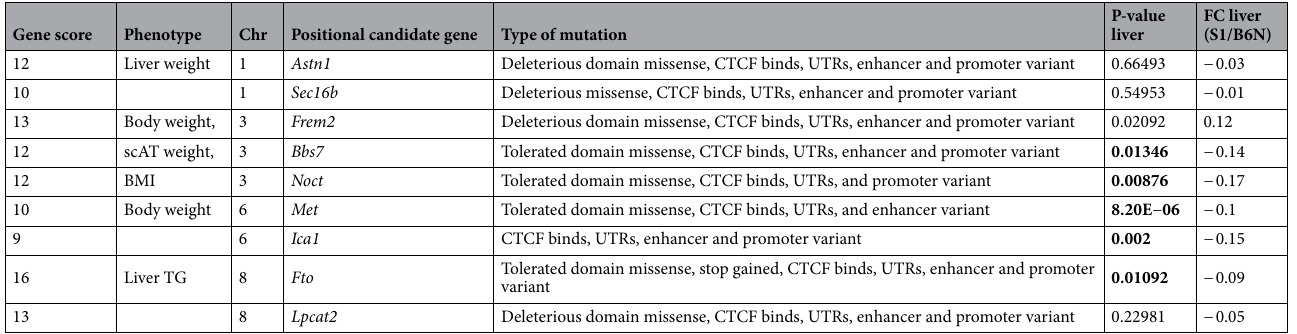
Table 4. Top candidate genes after applying the prioritization criteria. Bold indicates differentially expressed in liver after Benjamini–Hochberg correction. scAT, subcutaneous adipose tissue; TG, triglycerides; BMI, body mass index; Chr, chromosome; FC, fold